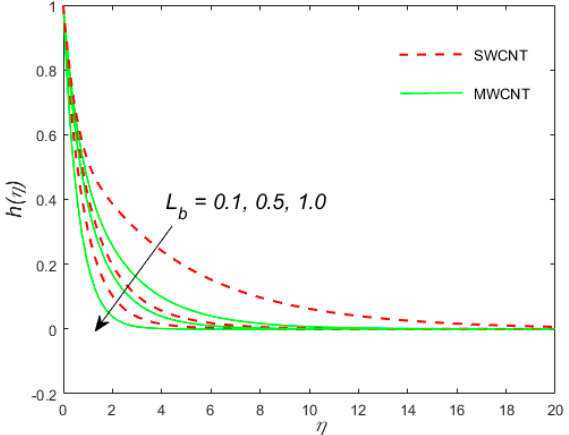
Figure 19. The variation of the local density of motile microorganisms h ( η ) for the case of SWCNT and MWCNT versus the similarity variable for the distinct values of the bio-convection Lewis number L b .